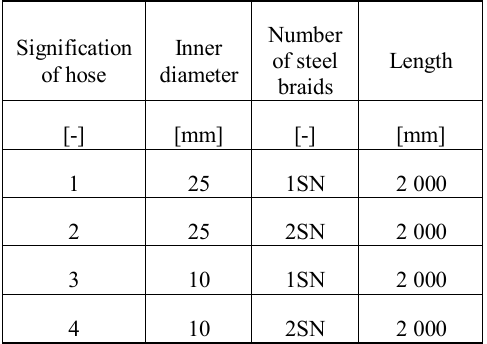
Table 2. Parameters of used hydraulic